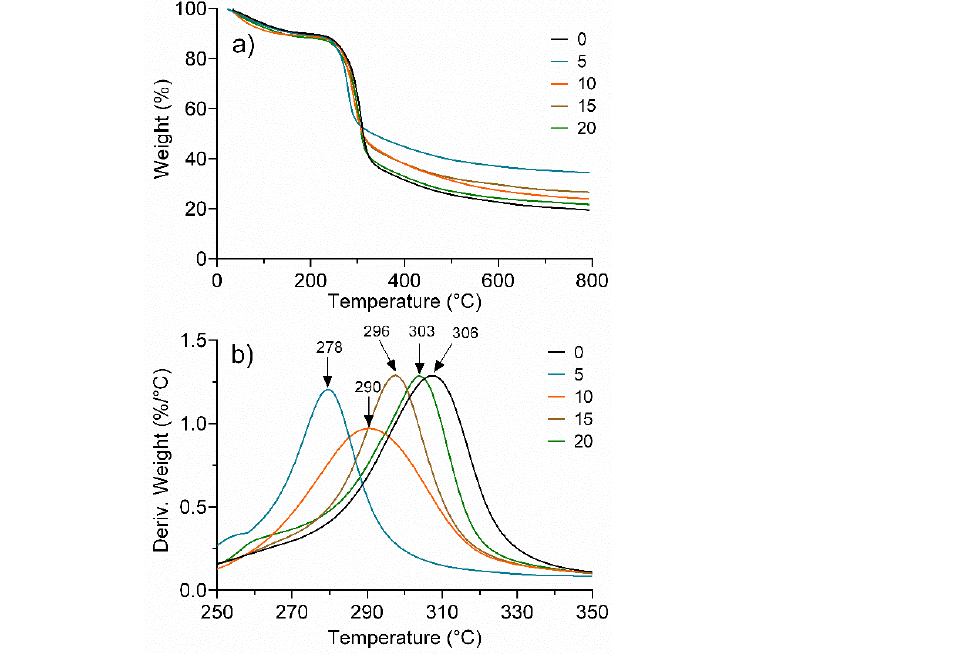
Figure 2. Effect of UV radiation time (0, 5, 10, 15, and 20 min) on the thermal stability of regenerated cellulose. ( a ) TG and ( b ) DTG.